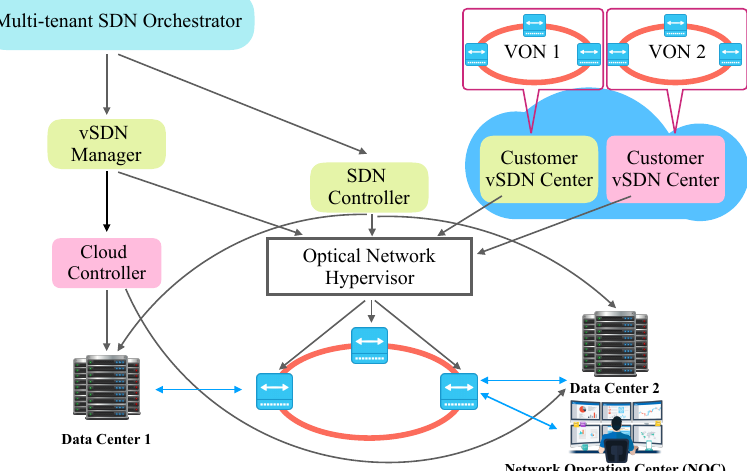
Figure 5. SDN/NFV Orchestration Architecture for Multi-tenant Optical Transport Networks with Virtual SDN Controllers